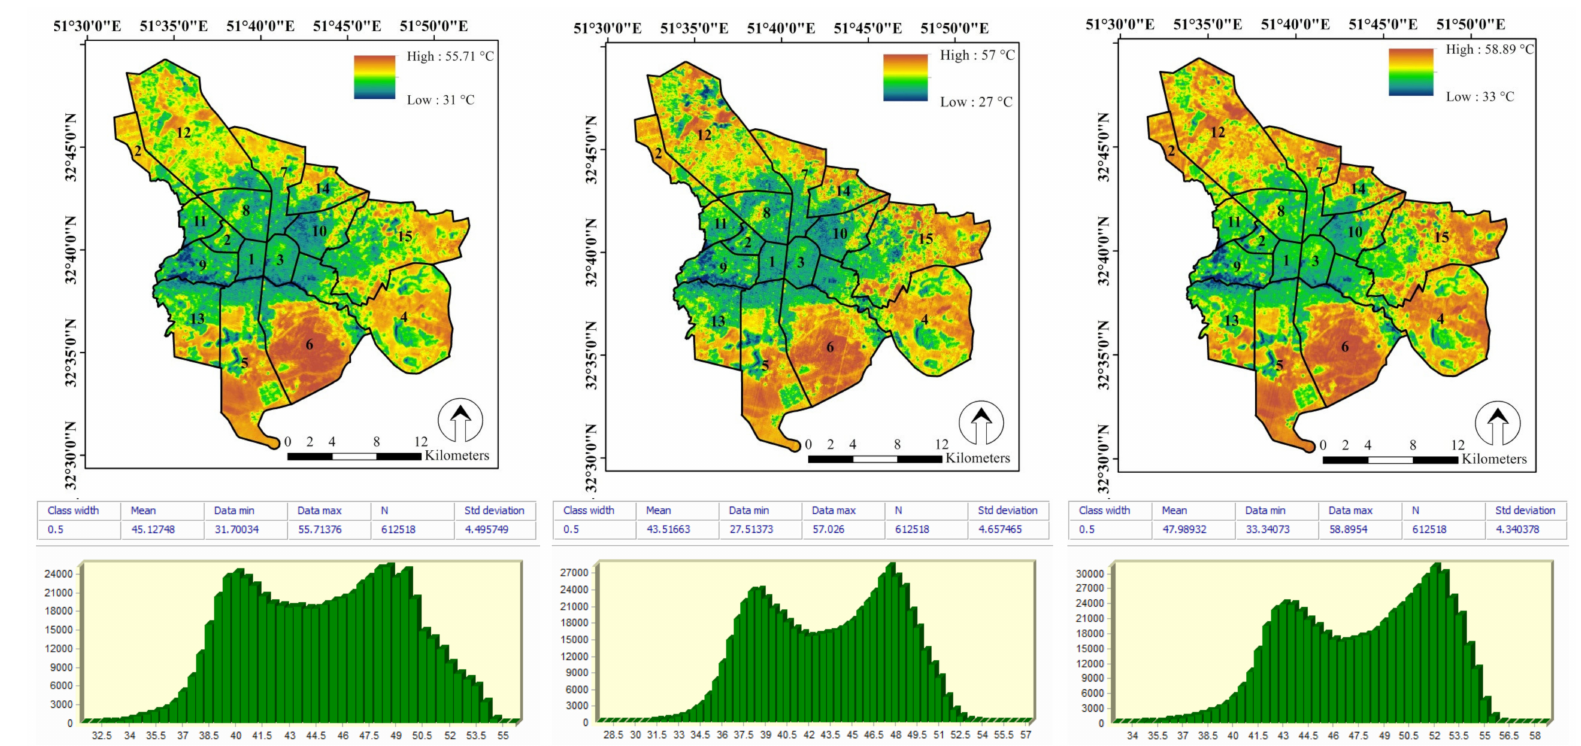
Figure 3. Mean LST maps of 2016, 2017, and 2018 (n = 3) and summary statistics of them (Vertical axis: No. of pixel, Horizontal axis: temperature in ◦